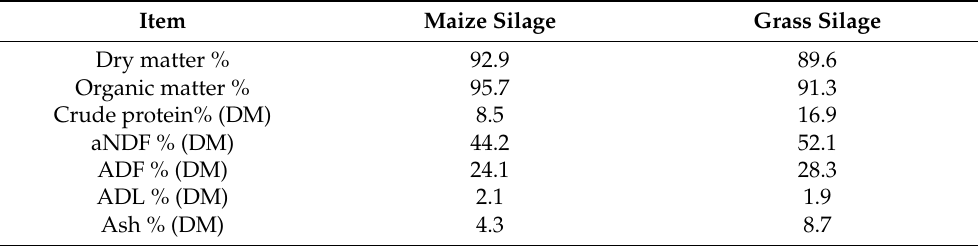
Table 1. Chemical composition of the feeds (% organic matter (OM) or % dry matter (DM)). Item Maize Silage Grass Silage Dry matter % 92.9 89.6 Organic matter % 95.7 91.3 Crude protein%